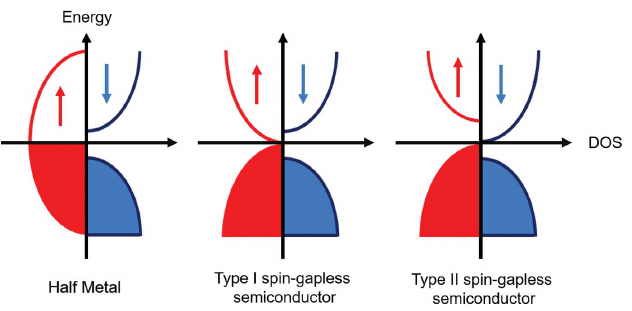
Figure 2 Schematic density of states diagrams for a half metal and the two types of spin-gapless semiconductor found in the M CoV Z Heuslers studied by Wang et al